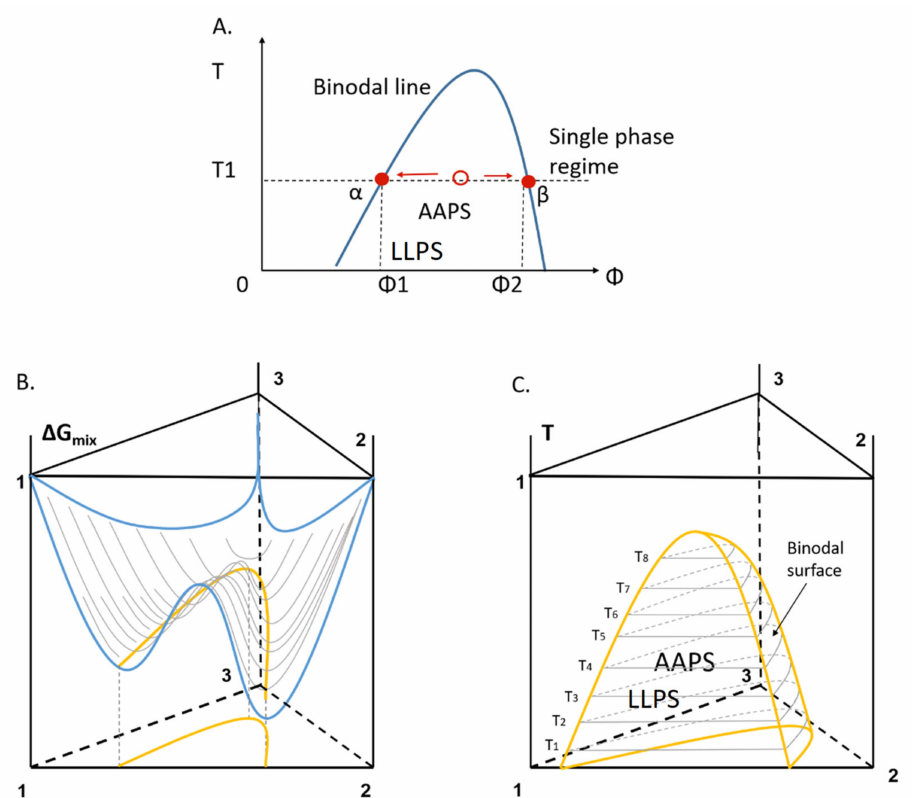
Figure 2. ( A ) Schematic diagram of the binodal line reflecting the boundary of a single homogeneous phase and AAPS/LLPS for an amorphous-amorphous binary system consisting of an upper critical solution temperature (UCST). ( B ) Gibbs free energy landscape of drug-polymer-water ternary system at a constant temperature, where the solid blue line describes the free energy surface, and the solid yellow line represents the binodal line at this temperature. ( C ) Composition-temperature phase diagram of the ternary system. The binodal surfaces are labeled with the solid yellow lines (components 1, 2 and 3 represent drug, polymer, and water,